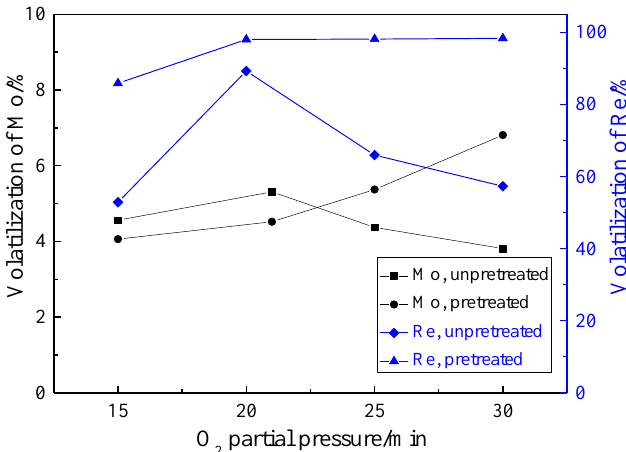
Figure 9. Effect of O 2 partial pressure on the volatilization of Mo and Re.